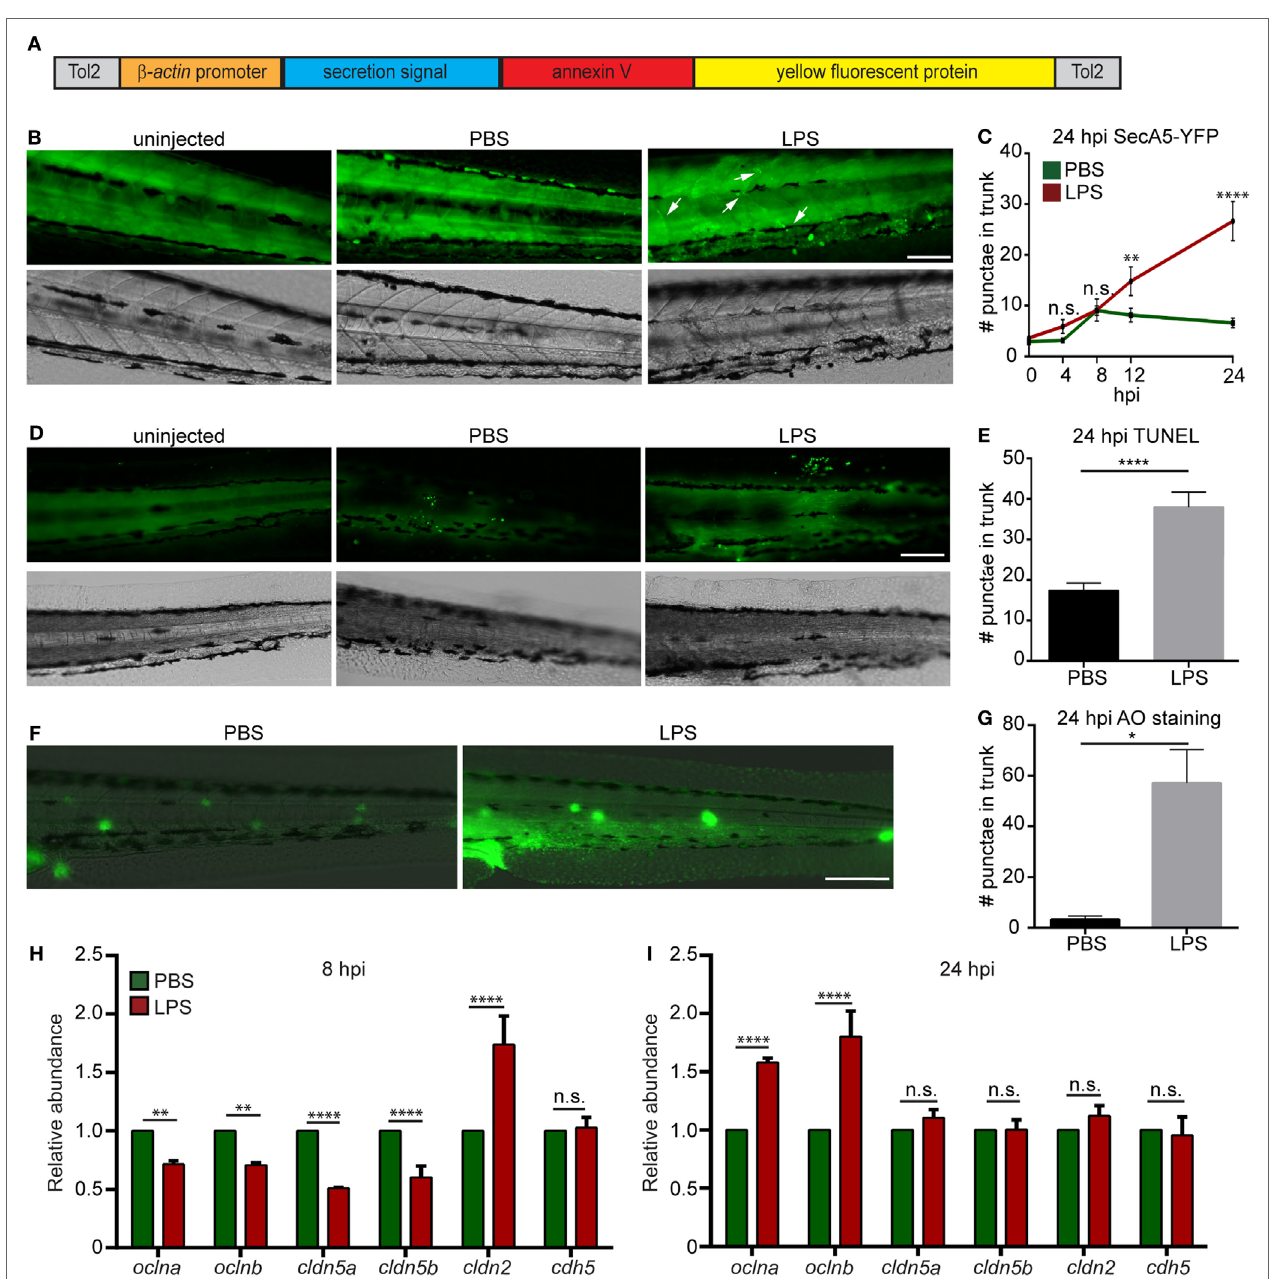
FigUre 3 | Lipopolysaccharide (LPS) induces tissue damage. (a) Diagram of the construct used to generate the apoptosis reporter line where a secreted AnnexinV tagged with a YFP protein is driven by the β -actin promoter. (B,c) Tg ( β -actin:secANV-YFP) were injected with PBS or LPS. Representative images (B) and quantification (c) of the YFP-positive foci in trunks at indicated time points post injection. (D–g) WT zebra fish larvae were injected with PBS or LPS. Representative images (D) and quantification (e) of terminal deoxynucleotidyl transferase-mediated dUTP-biotin Nick End Labeling (TUNEL)-positive cells in the trunk at 24 hours post injection (hpi). Representative images (F) and quantification (g) of the Acridine Orange (AO)-positive cells in the trunk at 24 hpi Scale bar: 100 µm. Results are presented as mean ± SEM ( n = 3 independent experiments with over 20 larvae each/experiment). * p < 0.05, **** p < 0.0001, Mann–Whitney test. (B,D,F) Images representative of three independent experiments were shown ( n = 20). (h,i) Transcript levels of genes encoding vascular and cell junction proteins in whole larvae injected with either PBS or LPS at 8 hpi (h) and 24 hpi (i) . Results were normalized with ef1 α and are presented as means ± SD (D) ( n = 3 biological repeats with 20 larvae in each group). ** p < 0.01, *** p < 0.001, **** p < 0.0001, Sidak’s multiple comparisons